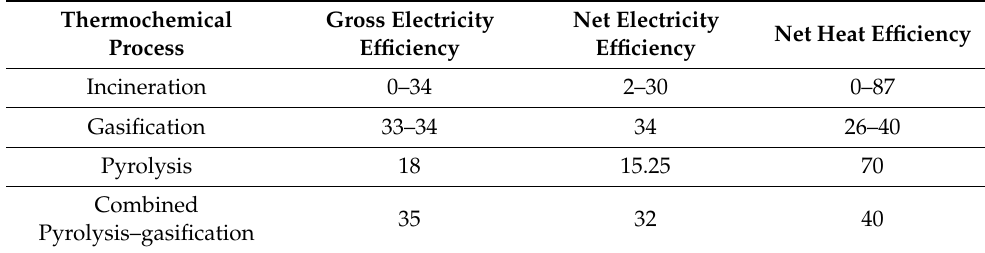
Table 8. Thermal and electrical efficiencies for WTE methods based Aspen HYSYS simulation